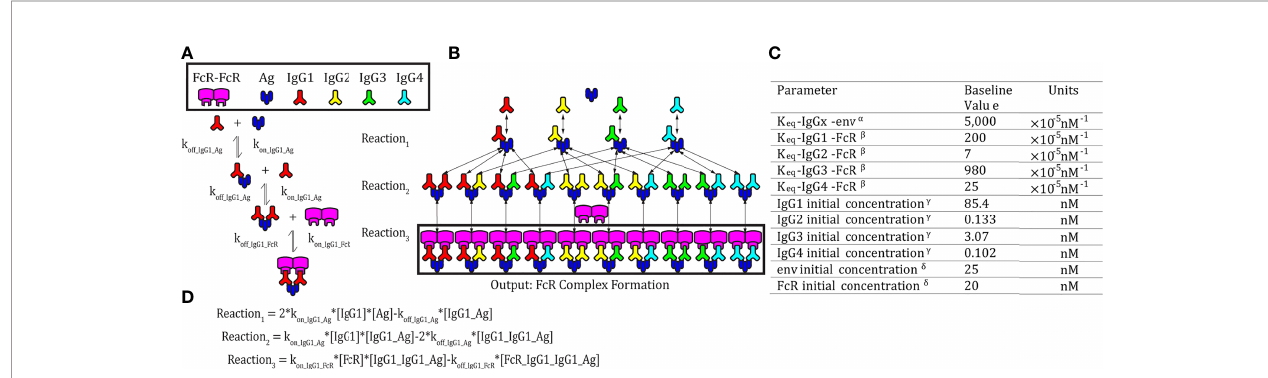
FIGURE 1 | Model schematic. (A) An example set of reversible reactions describing the sequential binding of IgG1 to antigen (Ag) and dimeric Fc g R with the respective forward (k on ) and reverse (k off ) reaction rates. (B) Ordinary differential equations were used to predict total HIV Ag-IgG-Fc g R complexes formed as a function of concentration and binding af fi nity of Ag, IgG subclasses, and Fc g R. The model assumes a single Fc g R type. Reversible reactions are represented by double ended arrows. Model output was the sum of all dimeric Fc g R complexes formed (boxed in black) at steady state. (C) The baseline parameters for Fc g RIIIA- V 158 complex formation with the following sources: a SPR measurement from pooled puri fi ed IgG from HIV infected individuals binding to monomeric gp120. All IgG subtypes share one af fi nity value to the antigen of focus, gp120 env (unpublished data). b K eq measured in Bruhns et al. (11). g The average estimated IgG concentrations from individuals 1-30 in the RV144 data in this manuscript (see methods for notes on conversion from MFI to mM unit). d Concentrations used in multiplex experimental protocol. (D) Equations describing the example reactions in panel (A) Reactions follow mass action kinetics and consist of a forward reaction (on rate, k on , multiplied by the concentrations of substrates) and a reverse reaction (off rate, k off , multiplied by the concentration of the product of the forward reaction). Differential equations for change in each complex over time were generated for each